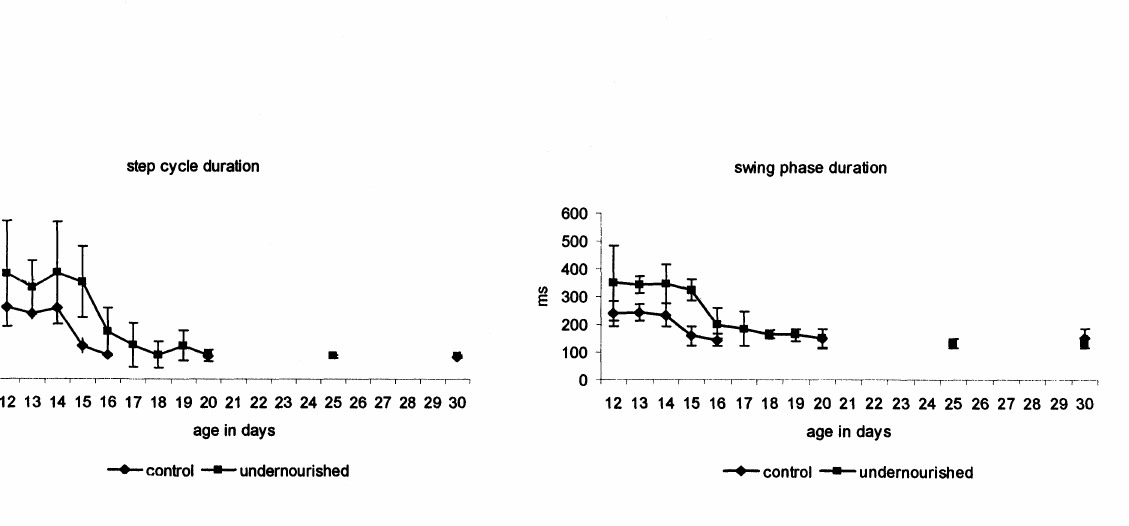
Left panel: mean and SD of the step cycle duration in undemourished and control rats; durations in ms; age in days. Right panel: mean and SD ofthe swing phase duration. Note that at P20, P25 and P30 the data on both groups are nearly identical (from, Gramsbergen and Westerga, 1992, and Westerga and Gramsbergen, 1990